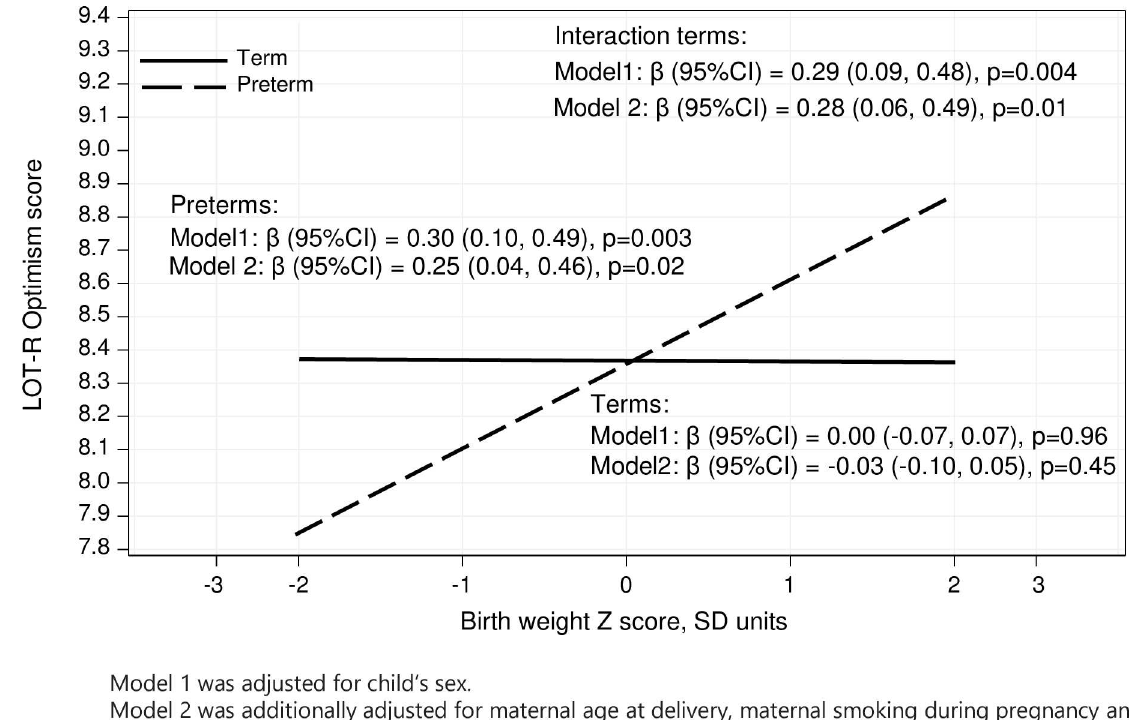
Fig 4. Preterm birth vs term birth and birth weight z-score interactions in the analysis of dispositional optimism.